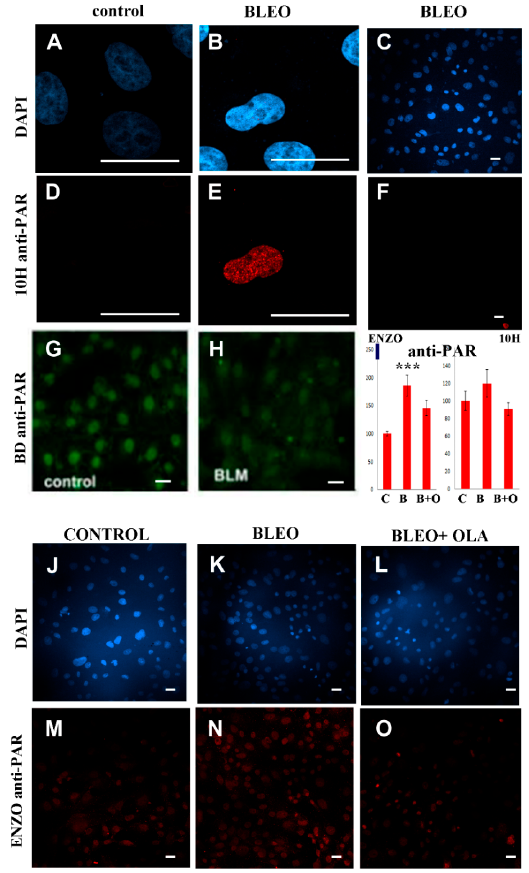
Figure 3. Neither of the three anti-PAR antibodies evidenced a sharp PAR increase using ICF after the BLEO (45 min) treatment. This was observed in at least five independent experiments. ( A , D ) control and ( B – F ) BLEO. ( G , H ) BD anti-PAR in ( G ) control or ( H ) BLEO-treated cells. ( I )